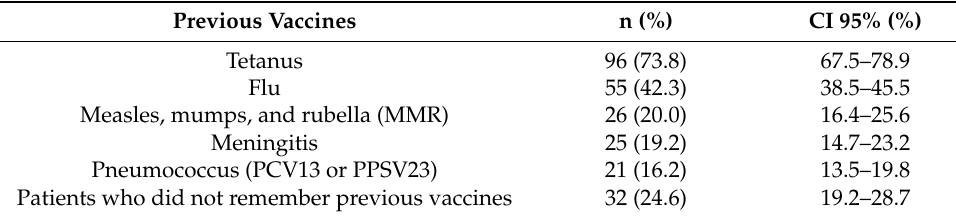
Table 3. Previous vaccinations among the study population with CD (n = 130).